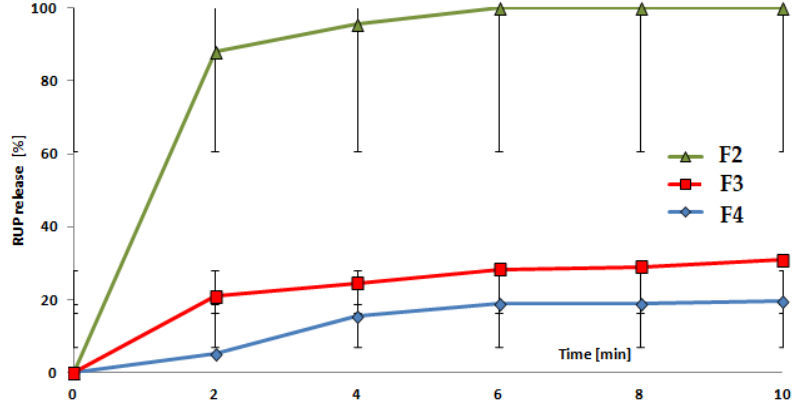
Figure 5. In vitro RUP release from ODFs: F2, F3, F4 conducted in paddle apparatus. 592